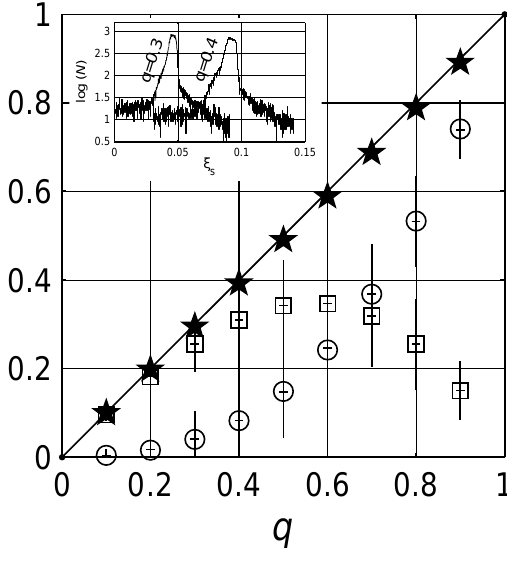
Figure 14 . The expected values of constants, q and ξ integral of g ( x ) yields the concentration of the inclusions q , denoted by open squares ( (cid:3) ). The expected value of percolation strength is ξ denoted by open circles ( ◦ ). Both values are also presented with error bars. Addition of the two expected values ξ ( (cid:70) ), leads to the actual concentration q as in Equation (20), which is denoted by the solid line (——–). In the inset, the number distributions of ξ each Monte Carlo cycle for q = 0 . 3 and q = 0 . 4 are illustrated with the most expected ξ being 0 . 041 ± 0 . 006 and 0 . 083 ± 0 . 015 , respectively, for the two